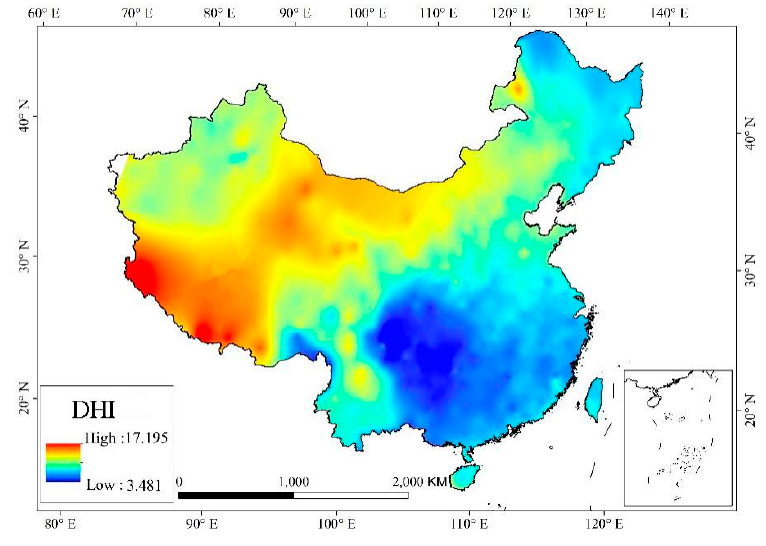
Figure 9. Spatial distribution of annual mean DHI (MJ m − 2 day − 1 ) across China.